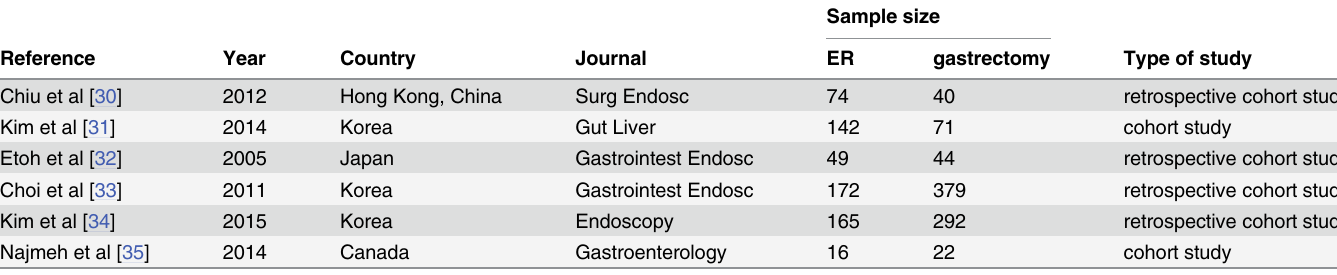
Table 1. Details of the articles